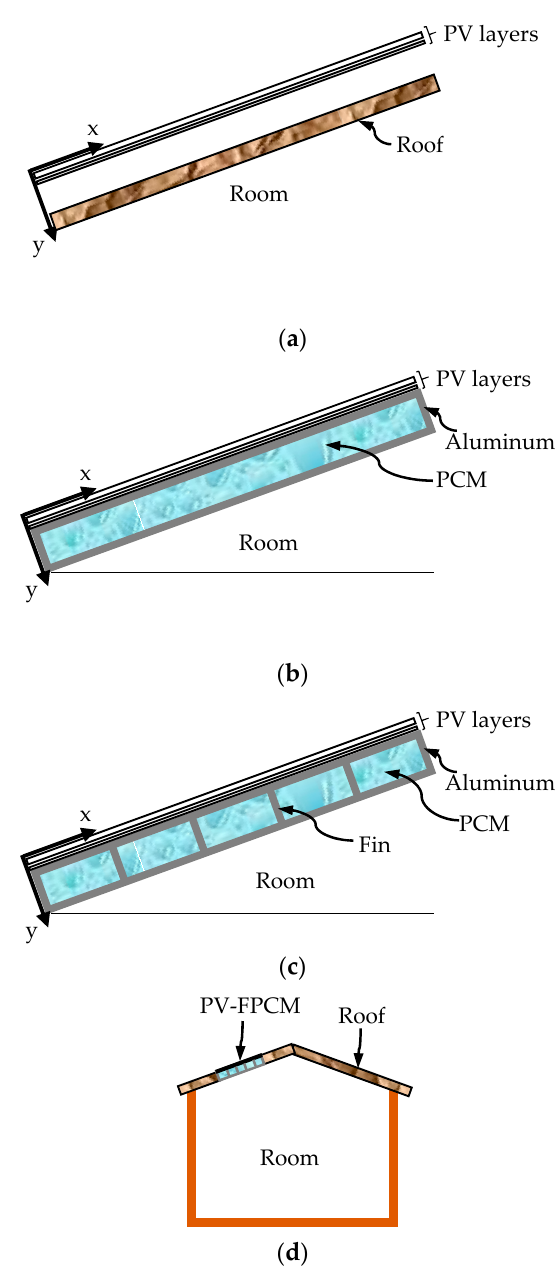
Figure 1. Studied systems: ( a ) photovoltaics (PV) panel of the first system; ( b ) PV-phase change material (PCM) panel of the second system; ( c ) PV-finned PCM (FPCM) panel of the third system; ( d ) schematic showing the integration of the PV-FPCM system to the roof. Table 1. Specifications of PCM, PV panel and PCM container.